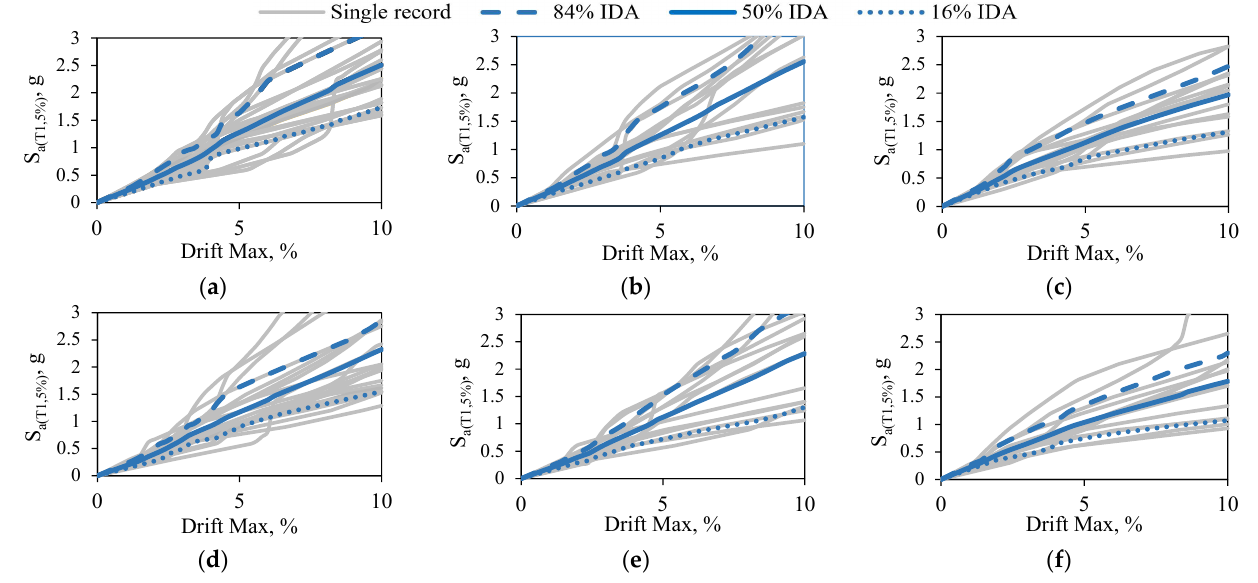
Figure 6. The 16%, 50%, and 84% fractile IDAs for 3-story initial and MRF03-1to3-1000a scenario models subjected to ( a , d ) FF, ( b , e ) NF-No Pulse, and ( c , f ) NF-Pulse records, respectively.